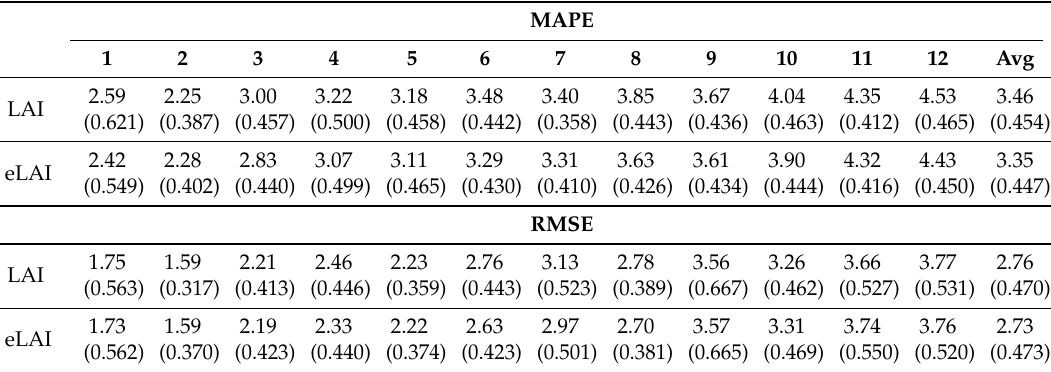
Table 2. Specific MAPE (%) and RMSE with information on the variation (numbers in parentheses are upper bounds of a 95% confidence interval).